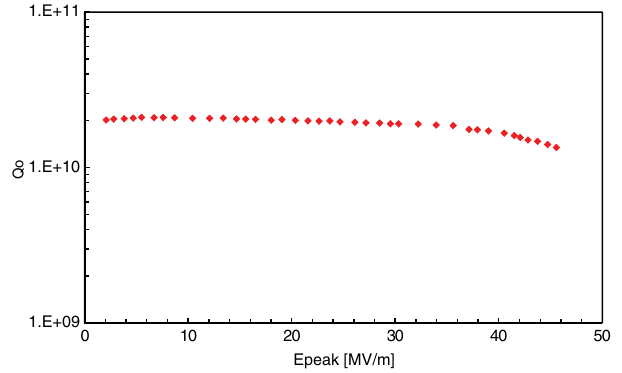
FIG. 17. Vertical test result of the 1.6 cell hybrid gun cavity with lead spot. Courtesy of Jacek